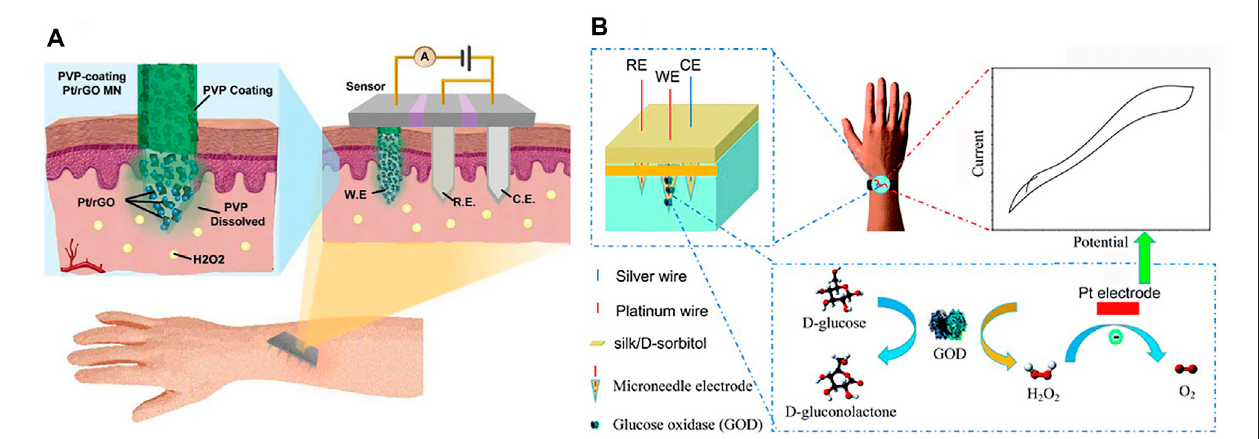
FIGURE 4 | (A) Schematics for illustration of the transdermal H 2 O 2 electrochemical biosensor on the basis of the conductive MN patch with Pt/rGO surface. Reproducedwithpermission(Jinetal.,2019).Copyright2019,Wiley. (B) Schematicsfortheworkingmechanismofsilk/D-sorbitolmicroneedleelectrodes.Reproduced with permission (Zhao et al., 2020). Copyright 2019, Royal Society of